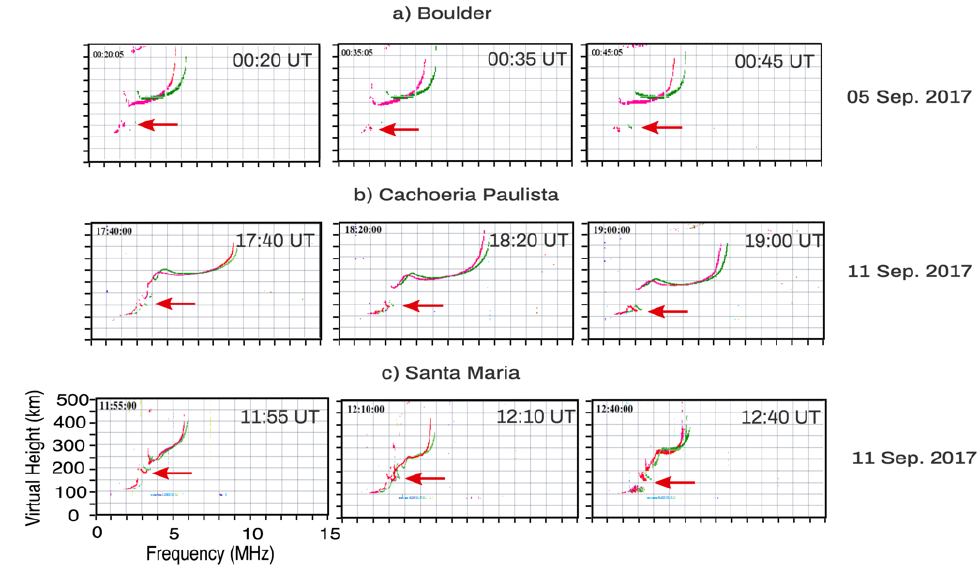
Figure 5. Ionograms collected at: ( a ) Boulder; ( b ) Cachoeira Paulista; and ( c ) Santa Maria show the downward movement due to the wind action.